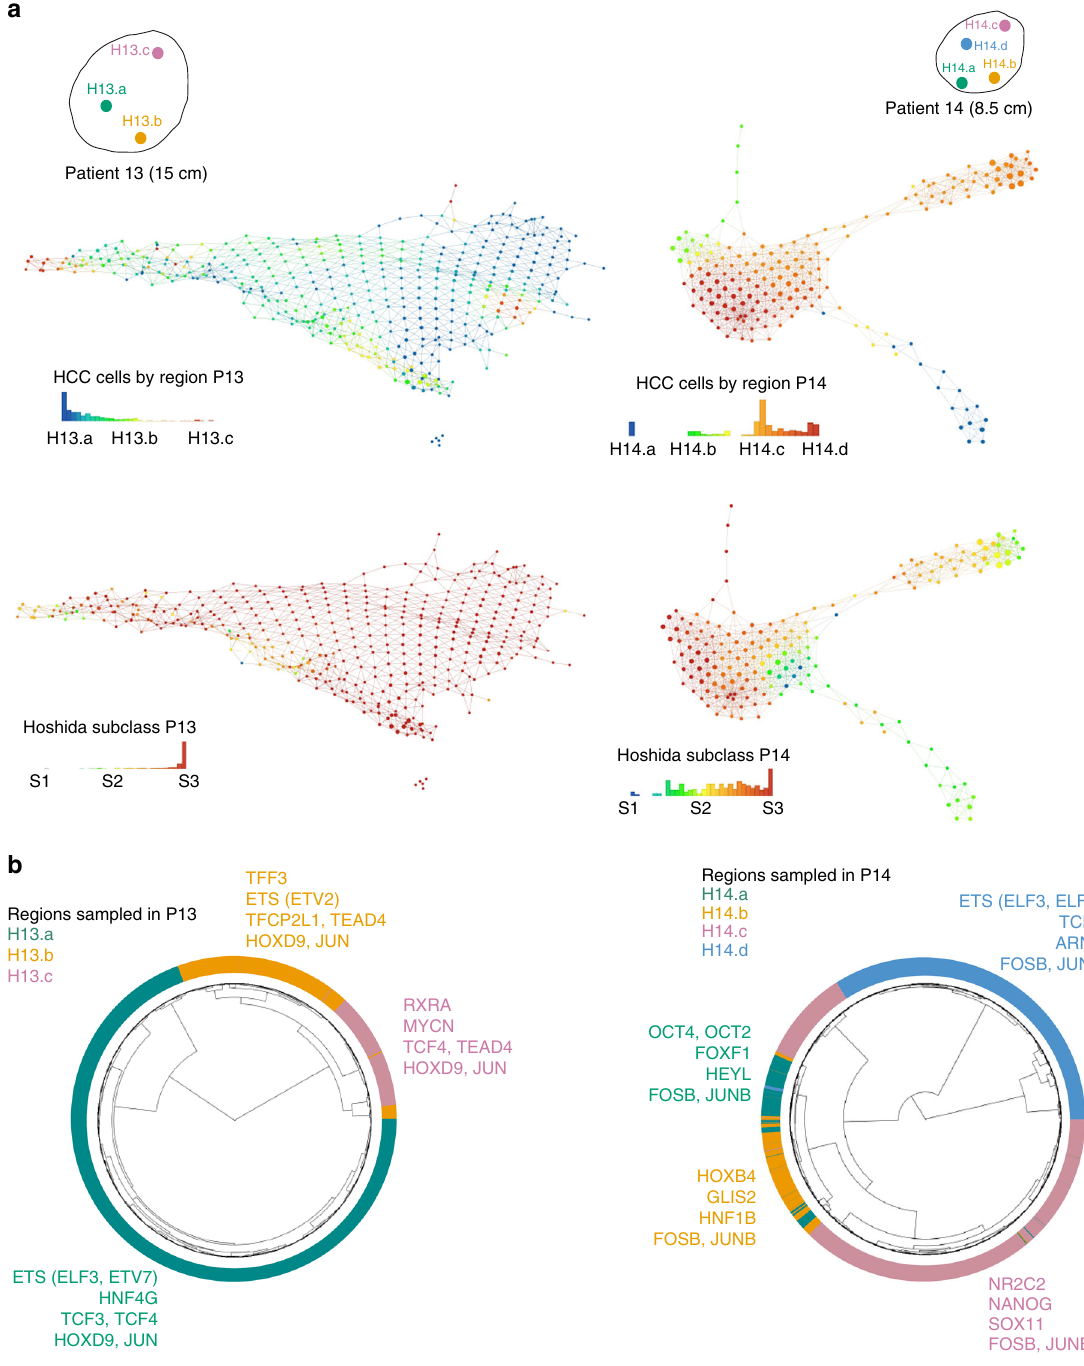
Fig. 7 Regulatory network heterogeneity at the single-cell level. a Geographic distribution of the multiregional sampling for single-cell RNA-seq. Topology data analysis of HCC-cell population across regions, as visualized with Ayasdi Platform 74 . Cells are labeled based on tumor region and molecular subclass. Each dot represents a node, the size of which corresponds to the number of cells that were clustered to form that node. Lines or edges between nodes indicate they have cells in common. b Circular hierarchical clustering of HCC cells based on the activation status of TF derived from regulatory networks using SCENIC 34 (H13.a: Green; H13.b: Yellow; H13.c: Pink). Source data are provided as a Source Data fi